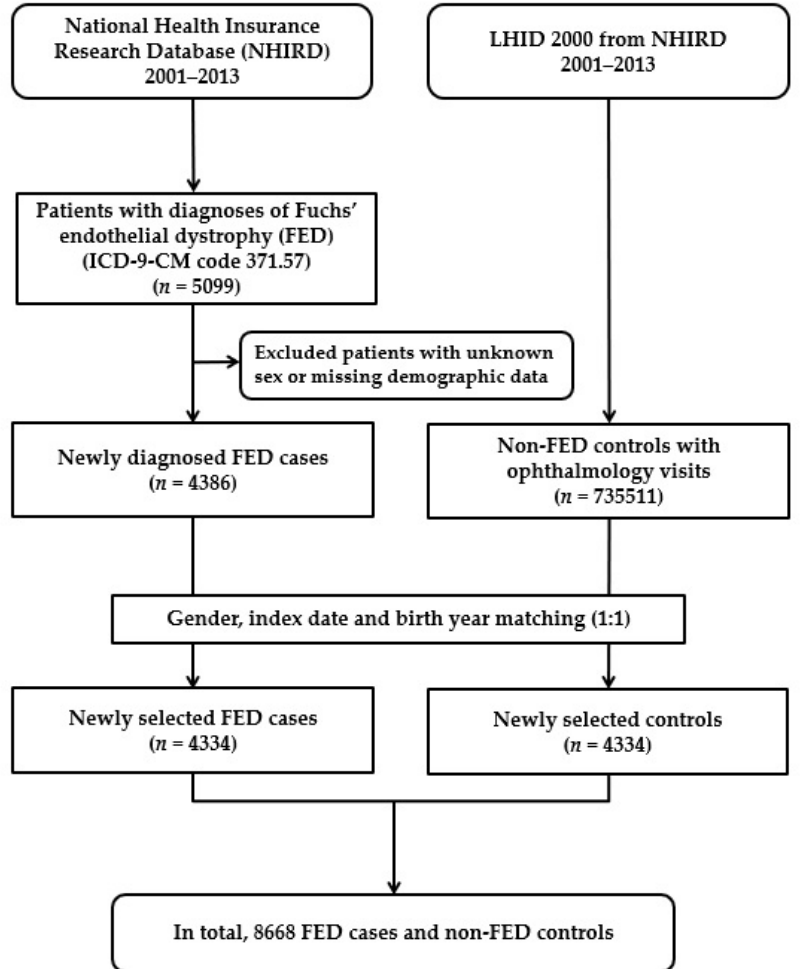
Figure 1. Flowchart demonstrating the enrollment of patients with Fuchs’ endothelial dystrophy (FED) and the control patients.